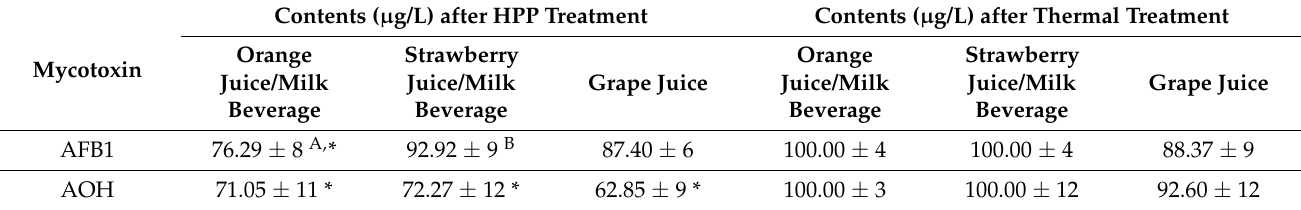
Table 2. Contents of AFB1 and AOH obtained after high-pressure processing (HPP) and thermal treatment in different juice models samples spiked at 100 µ